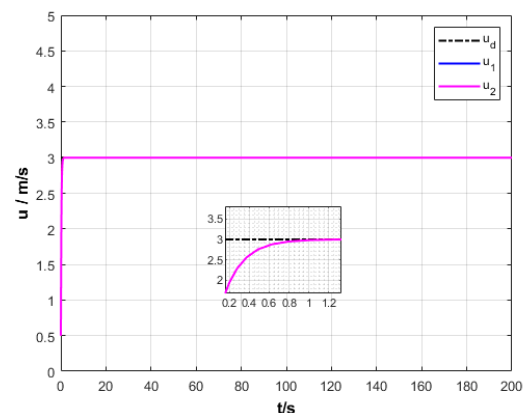
Figure 12. Relative longitudinal velocity variation of USV under two strategies.